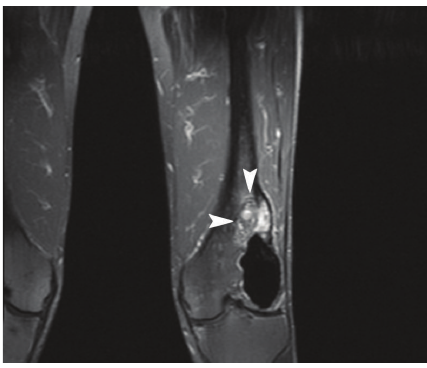
Figure 9: Coronal T1 postcontrast CT (November 2013) demon- stratedaheterogeneouslyenhancingsofttissuemass(arrows)within the lateral aspect of the distal femoral condyle, proximal to the hypointense focus of PMMA.